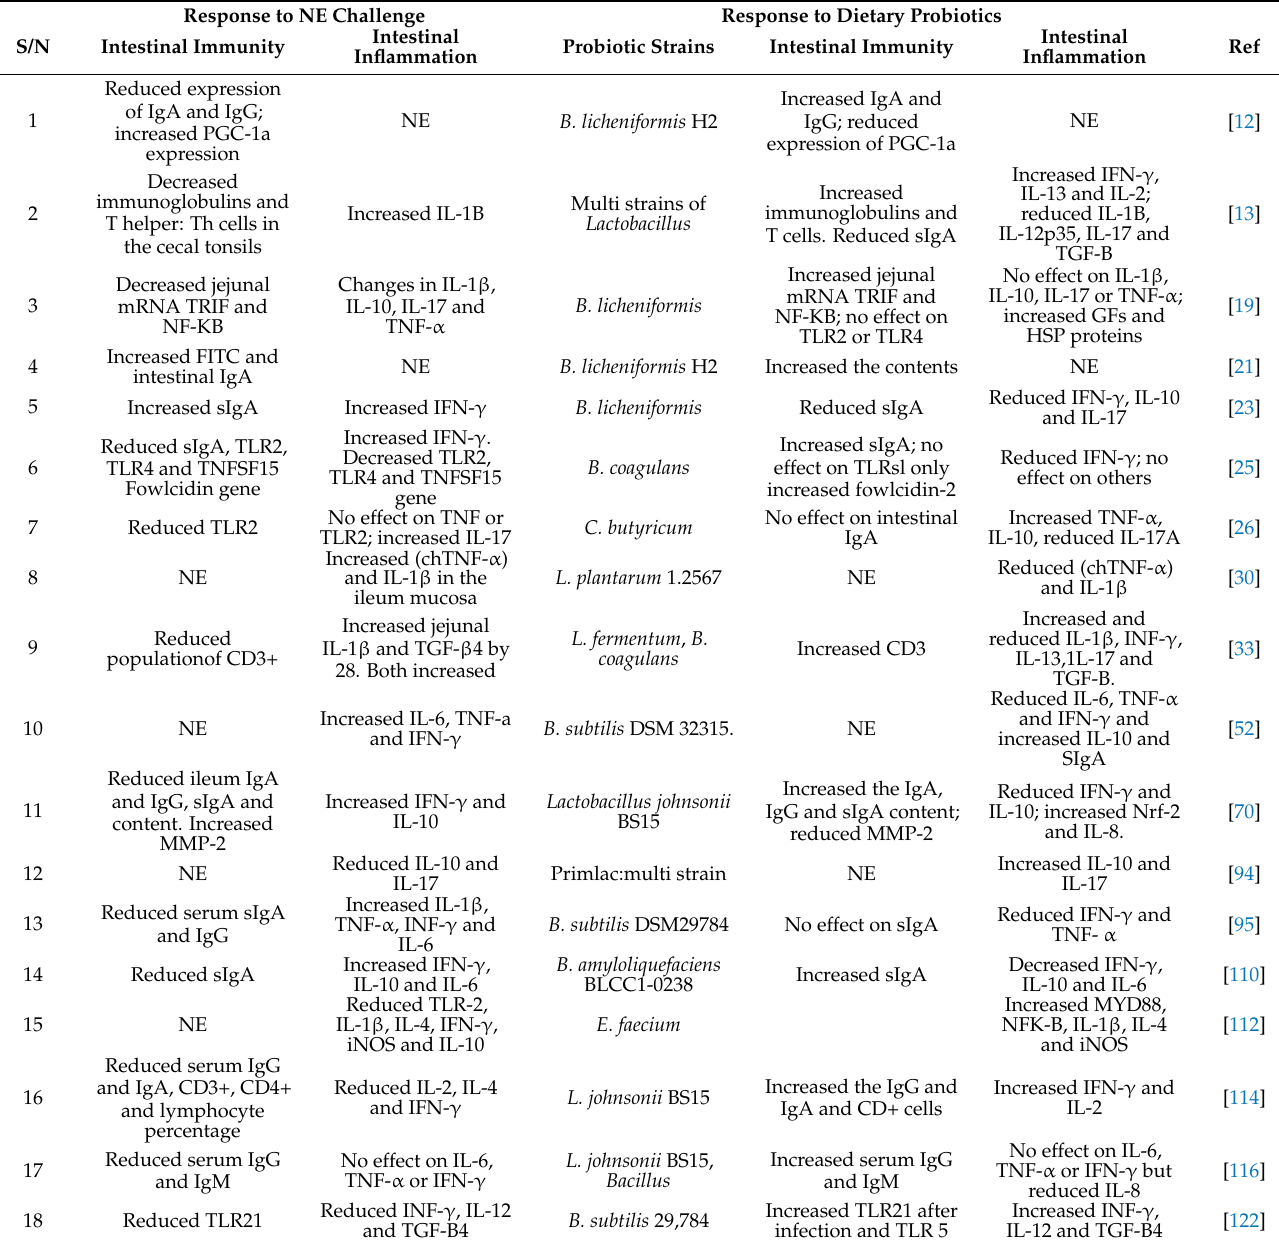
Table 5. Intestinal immune and inflammatory response to influence of NE challenge and modulation effect by